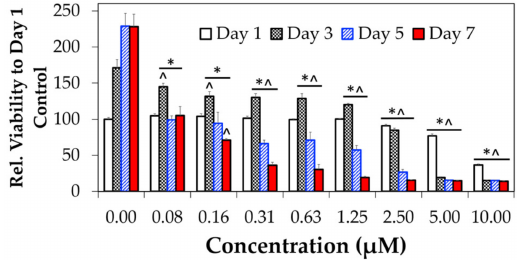
Figure 6. RA ReNcell VM (RVM) cell viability assessment results. Cell viability and proliferation profile measured with PrestoBlue TM after treatment with varying concentrations of retinoic acid. N = 3; error bars depicted as standard deviation (SD); * p < 0.05 compared to same day (group) control (0 µ M); ˆ p < 0.05 compared to day one control (0 µ